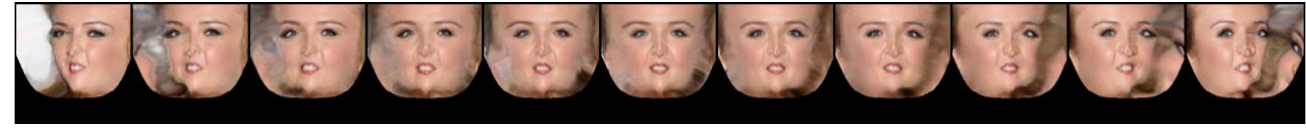
Figure 4. Unwrapped UV texture.